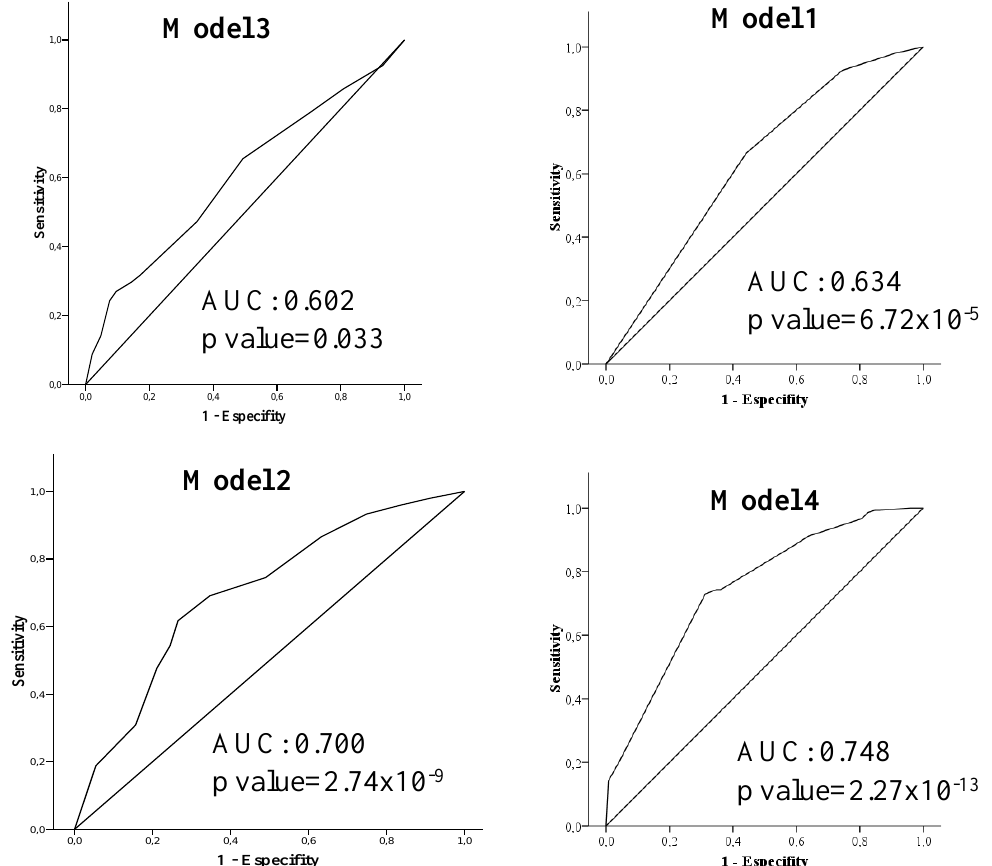
Figure 2. Receiver operating characteristics (ROC) curves generated from the logistic regression analysis to evaluate the models of MS risk. The discriminating power (the area under the ROC curve (AUC)) of the models performed was increased in the following order: model 3 (independent variable: HLA-DRB1*15:01 ), model 1 (independent variable: skin tone) and model 2 (independent variable: smoking habit). The predictive capacity was the highest in the multifactorial model 4 (independent variables: HLA-DRB1*15:01 , skin tone, smoking habit). J. Clin. Med. 2020 , 9 , x FOR PEER REVIEW